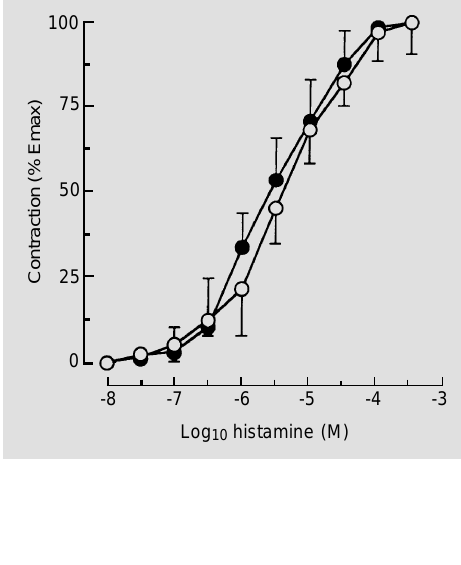
Figure 3 - Concentration-effect curves for methacholine in the absence (open circles) or pres- ence (closed circles) of L-argi- nine (100 mM) (A) or D-arginine (100 mM) (B) in guinea-pig iso- lated trachea. Each point repre- sents the mean of 4 observa- tions and vertical bars represent the SEM. Indomethacin (5 µM) is present